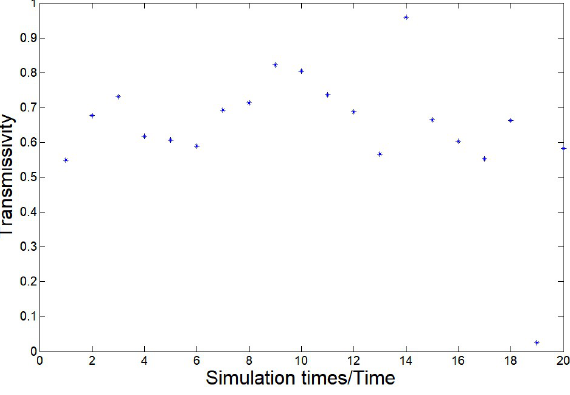
Fig 4 Transmissivity simulation of 1% Michaelis scattering